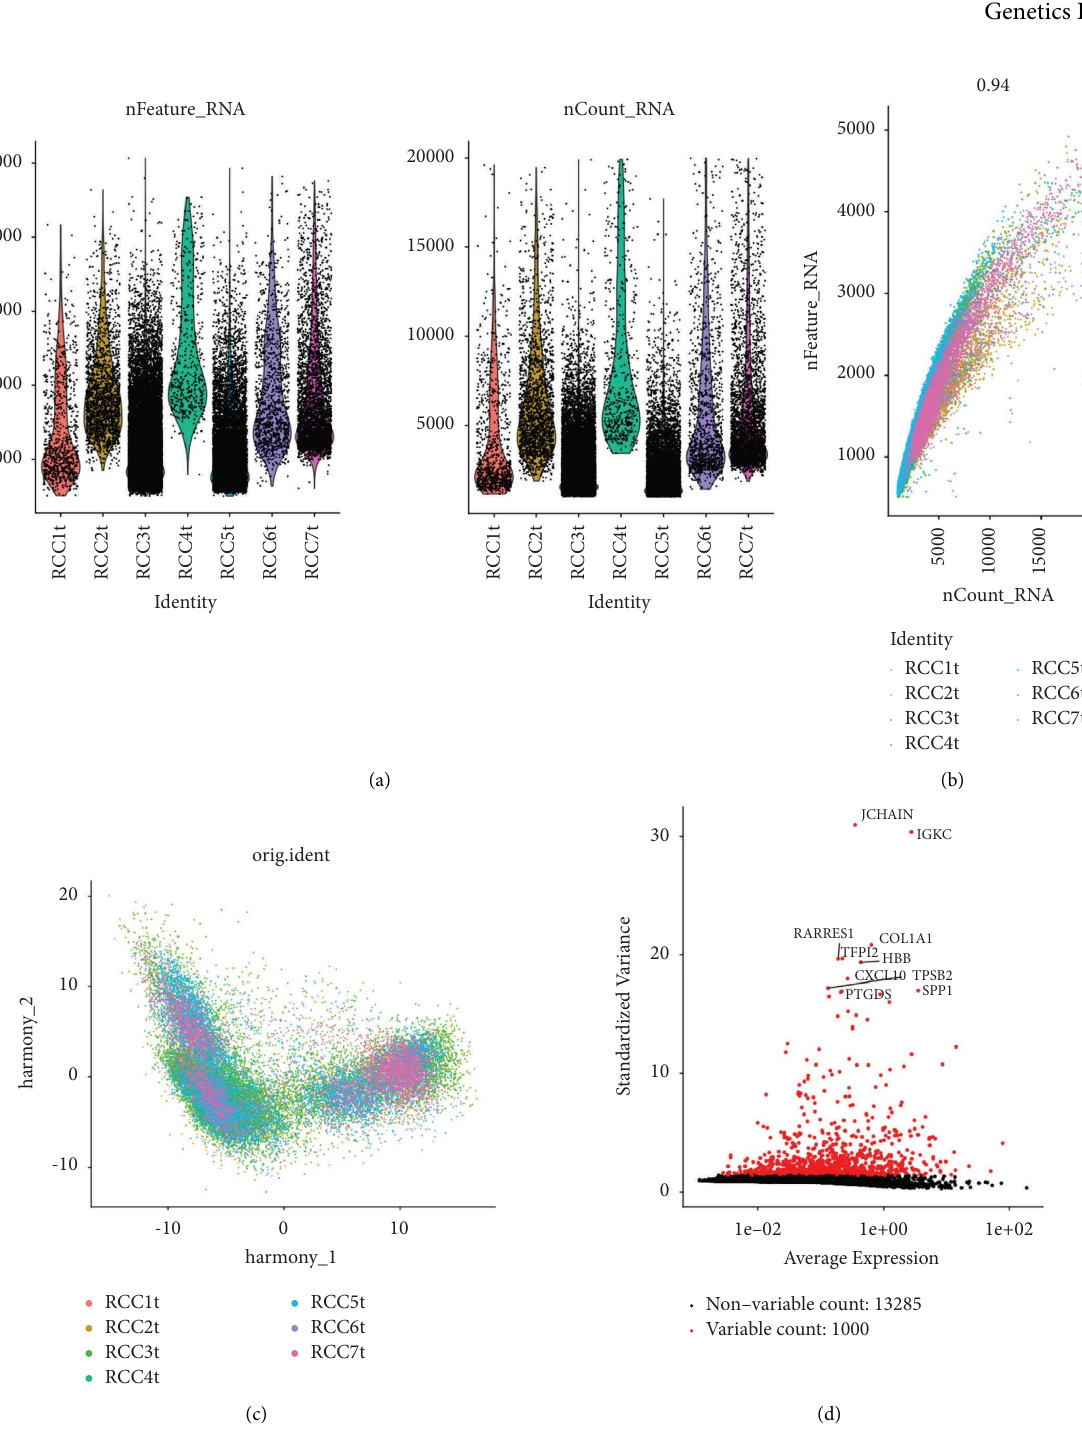
Figure 1: Preprocessing of the scRNA-seq data: (a) violin plots of the RNA information of processed scRNA-seq data, (b) scatter plot of the correlation between the numbers of detected genes and sequencing depth, (c) scatter plot of the batch efect after correction, and (d) scatter plot of 1,000 highly variable